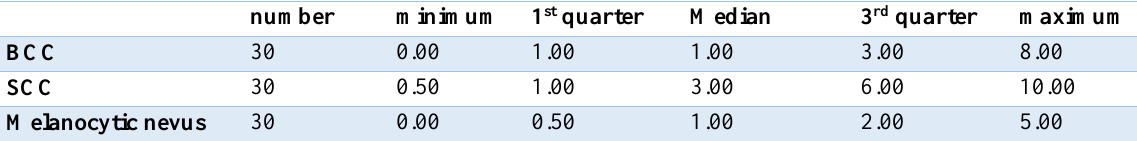
Table. 4. Statistics of p53 clone size (mm) in SCCs, BCCs and melanocytic